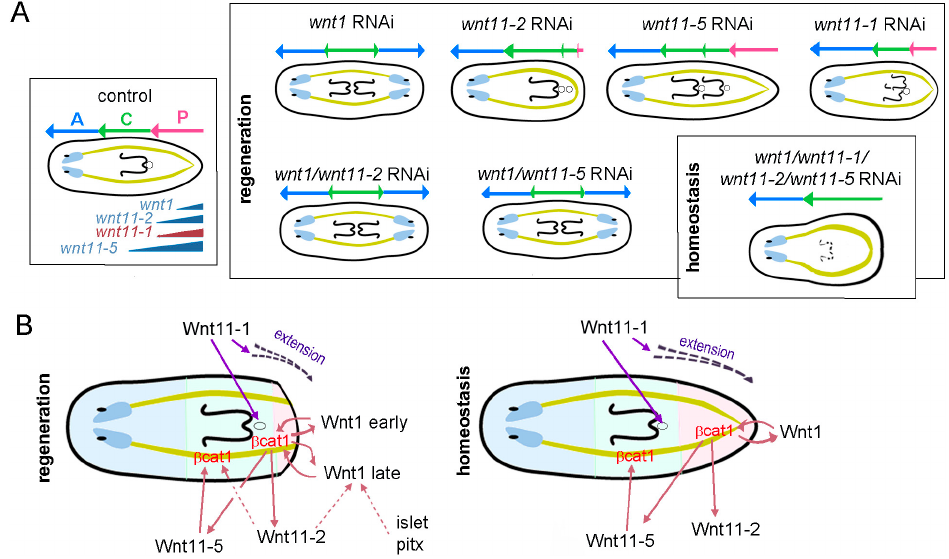
Figure 4. Summary and working model. ( A ) Scheme of the phenotypes generated after silencing the different posterior wnts (blue A, anterior; green C, central; pink P, posterior). The strongest phenotype is represented; ( B ) Proposed model of the function of posterior wnts in central and posterior specification and patterning (in the planarian: blue is anterior; green is central and pink is posterior).